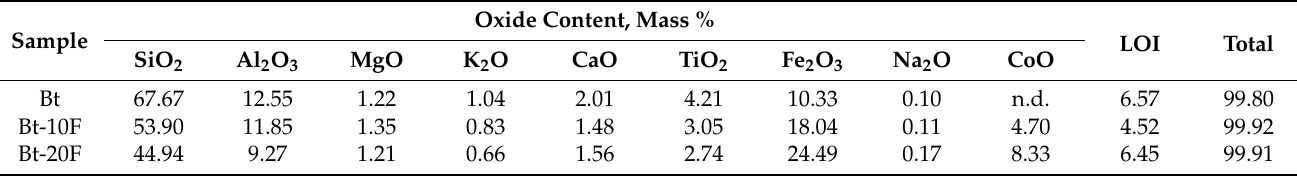
Table 1. Chemical compositions of clay material and composites